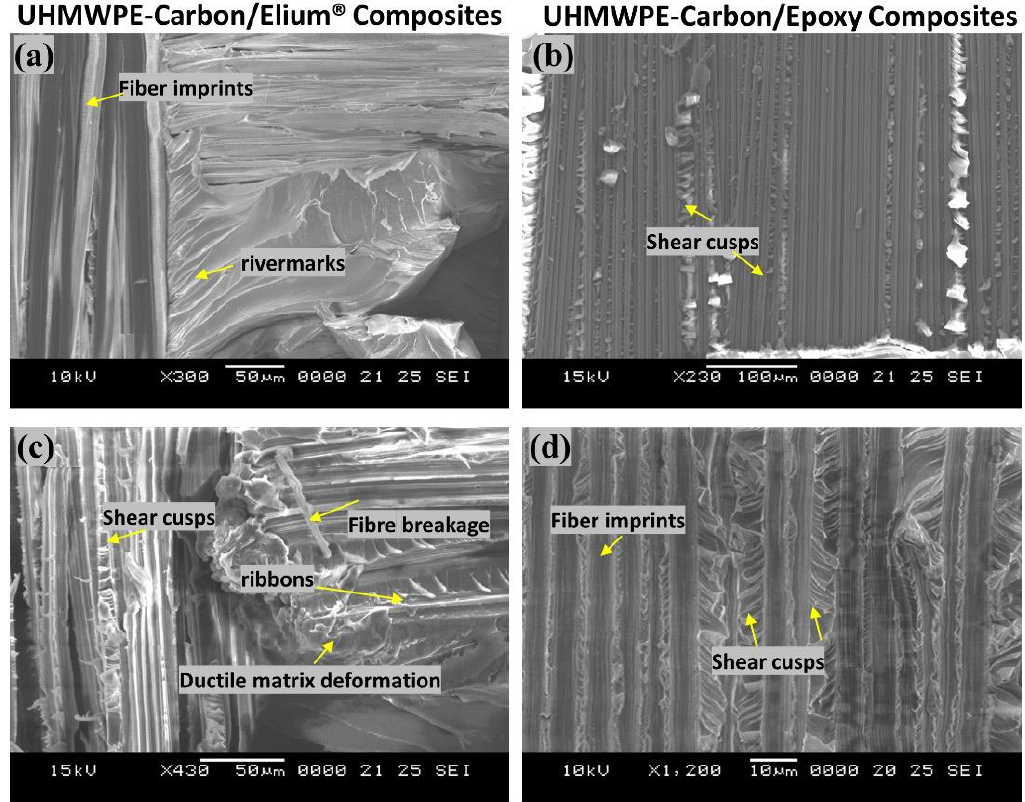
Figure 21 . Surface morphological images of fractured surfaces of composites using Scanning Elec- Figure 21. Surface morphological images of fractured surfaces of composites using Scan- tron Microscopic approach of ( a , c ) Carbon_UHMWPE/ Elium ® composite ( b , d ) Car- ning Electron Microscopic approach of ( a , c ) Carbon_UHMWPE/Elium ® composite ( b , d ) Car- bon_UHMWPE/Epoxy composite under Mode II loading . bon_UHMWPE/Epoxy composite under Mode II